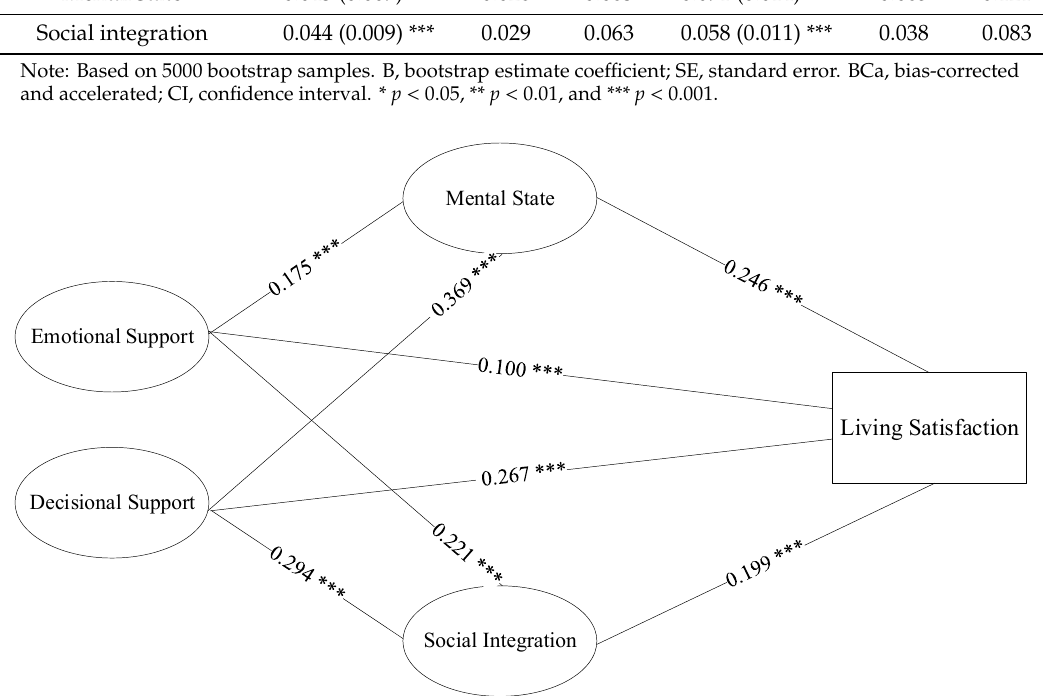
Figure 2. The mediating effect of multidimensional health on the relationship between family support and living satisfaction. Note: *** p <